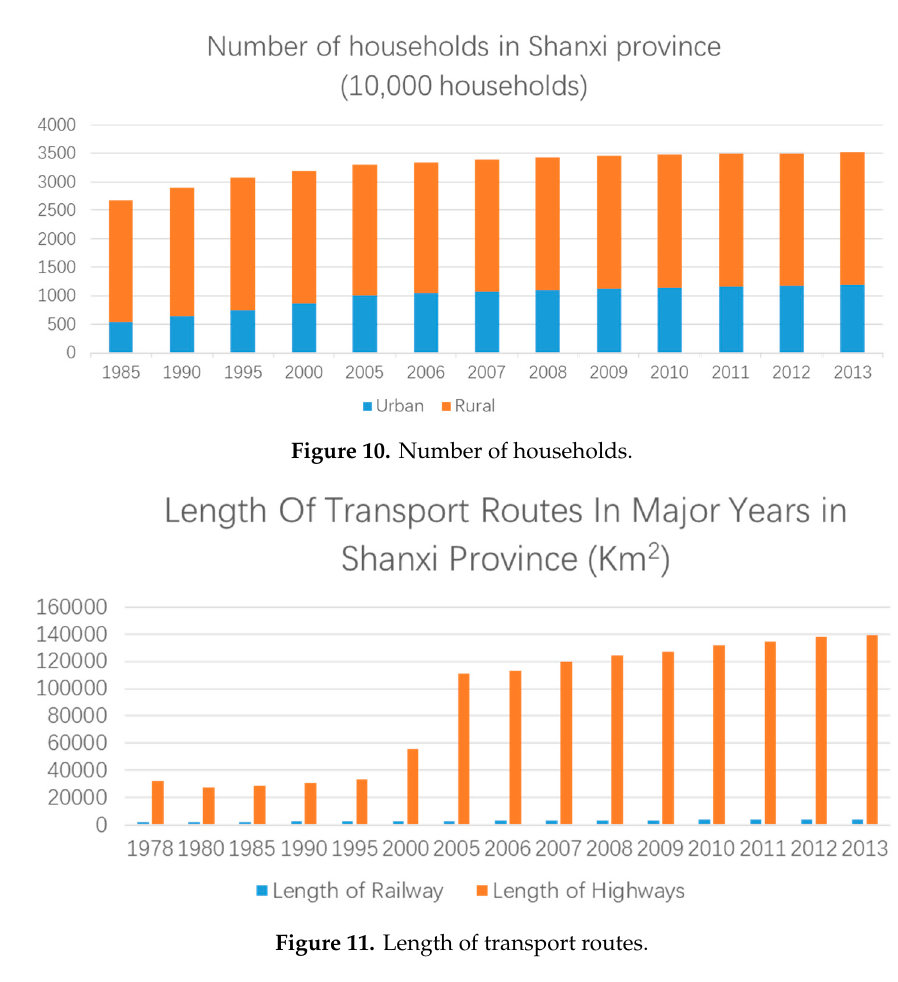
Figure 11. Length of transport routes.